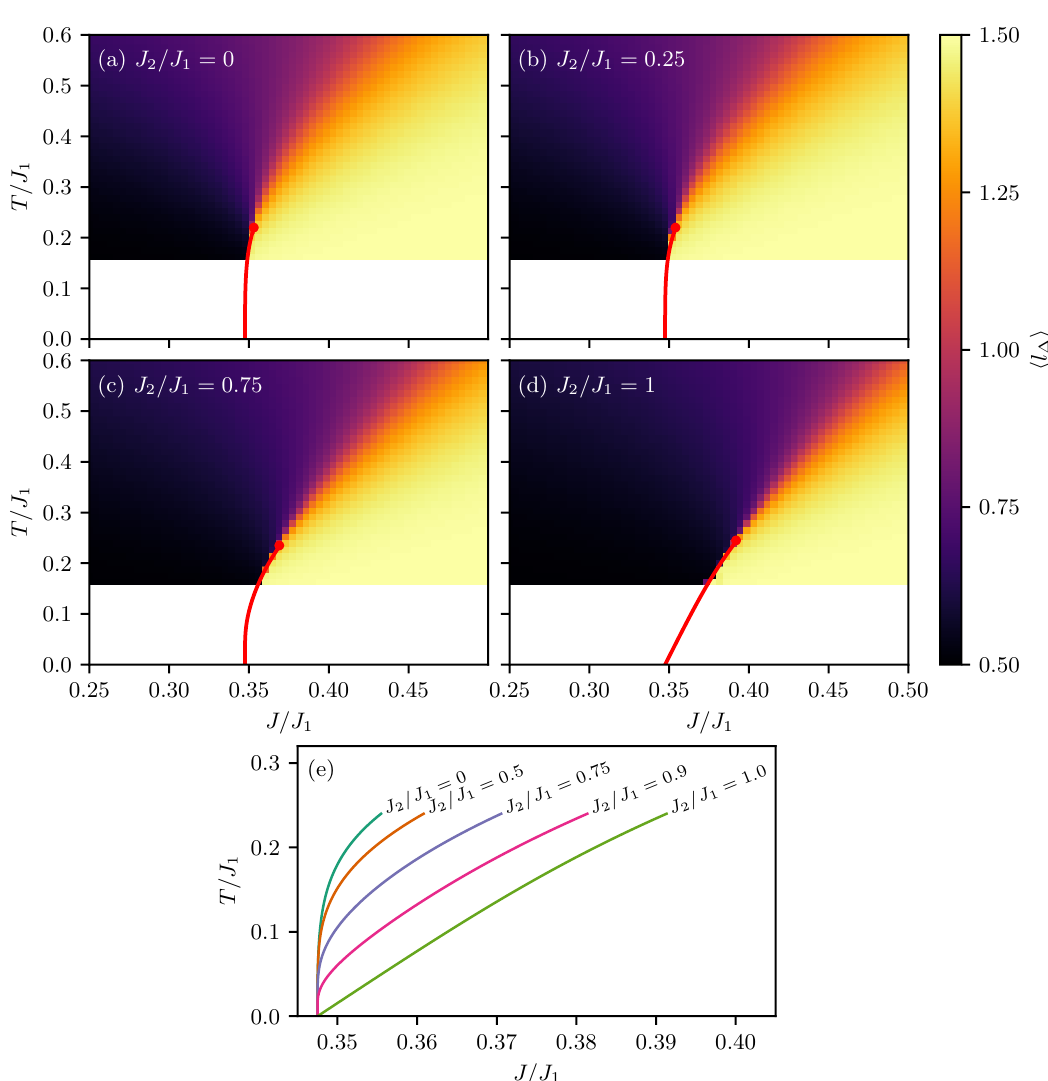
Figure 4: (a)-(d) Triangle total-spin quantum number, 〈 l ∆ 〉 , computed for the L = 12 FFTL model at different values of the intra-trimer coupling ratio J Red lines show the lines of first-order transitions at finite temperature, calculated from the approximation developed in Subsec. 4.1, and red circles mark the critical point determined numerically in Subsec. 4.2. (e) Comparison of the shapes of the first-order lines obtained for different J sec.